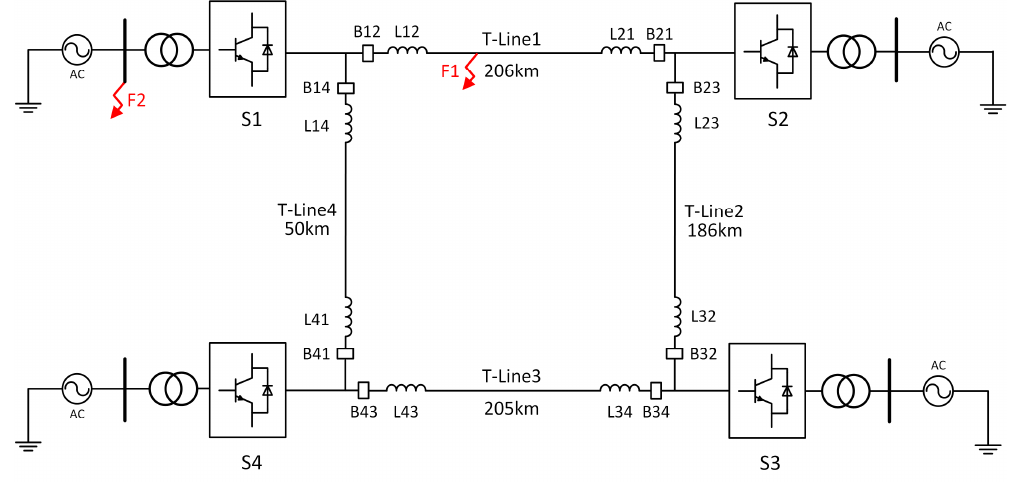
Figure 1. Netted four terminal MMC-MTDC transmission system.